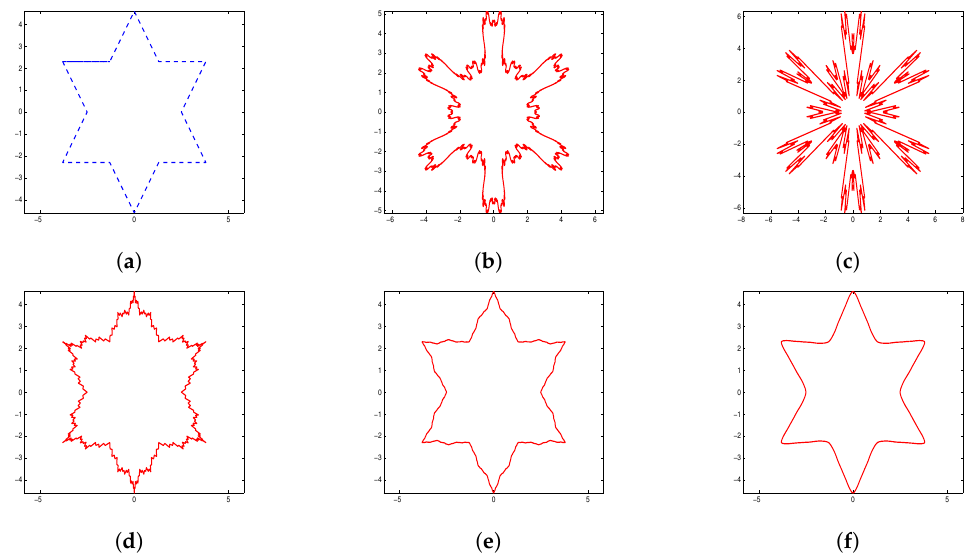
Figure 3. Example of the subdivision schemes with fractal behavior. ( a ) Control polygon; ( b ) Behavior of the schemes for α = 0.00792; ( c ) Behavior of the schemes for α = 0.00812; ( d ) Behavior of the schemes for α = 0.00823; ( e ) The limit curve with C 0 of the schemes for α = 0.01; ( f ) The limit curve with C 2 of the schemes for α = 0.007.